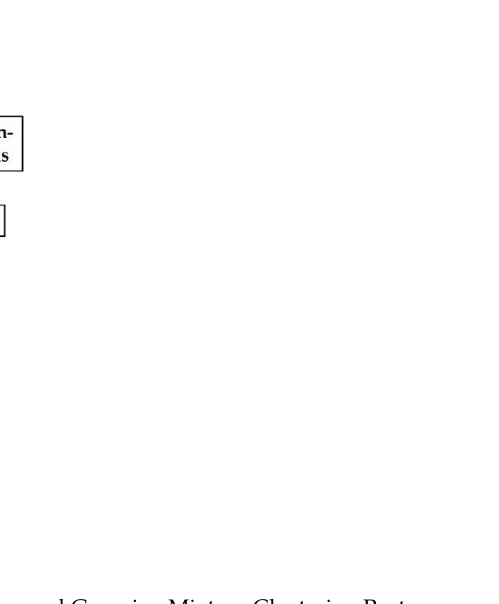
Figure 1. Predictive density is defined as the probability density of the observed variable 𝒒 𝒐 that is conditional on the hydrological model’s predictions, 𝒒 𝒔 , where 𝒒 𝒔 is considered to be known in the prediction time (adapted from Todini [14]).